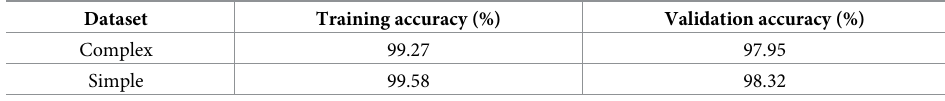
Table 3. Validation of the proposed model with two